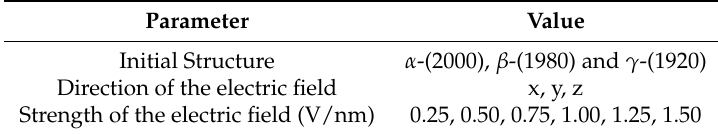
Table 1. Summary of the parameters that were tested in the simulations. The values in parentheses correspond to the number of molecules in the crystals used in the simulations.